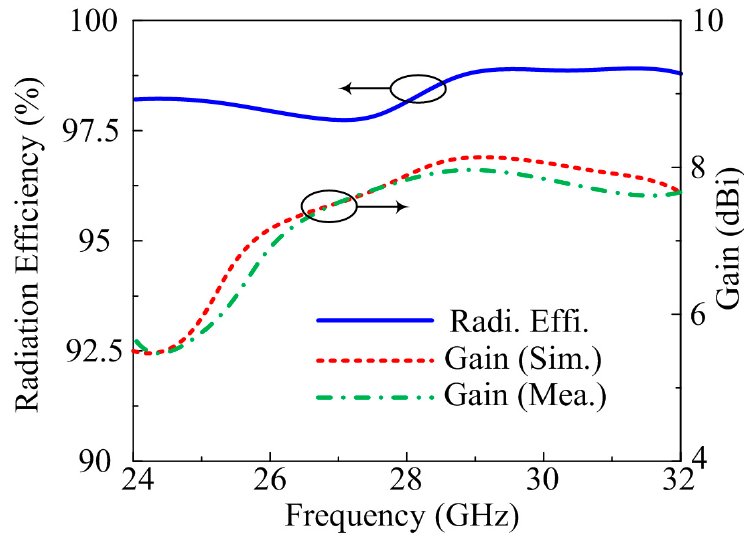
Figure 8. Comparison among gain and numerically calculated radiation efficiency of MIMO antenna of parallel placement of element. Figure 9. Schematic of MIMO antenna for inverted parallel placement of elements.